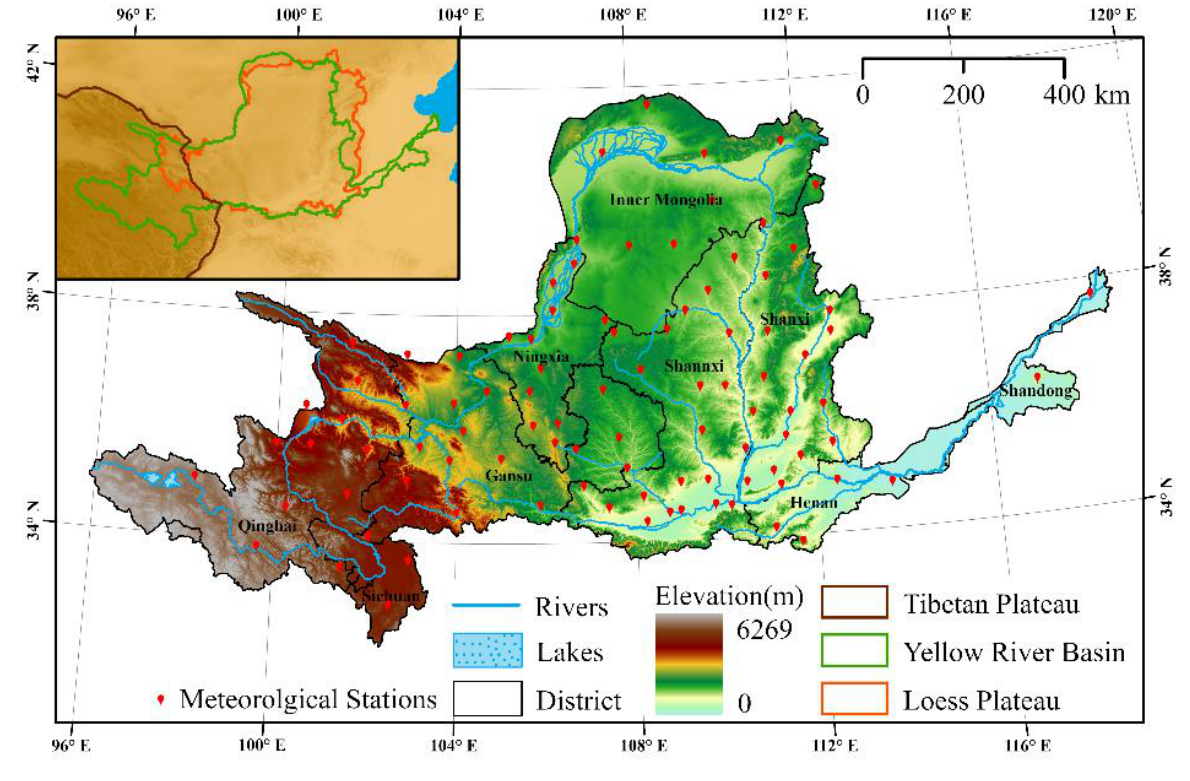
Figure 1. Overview of the study area.